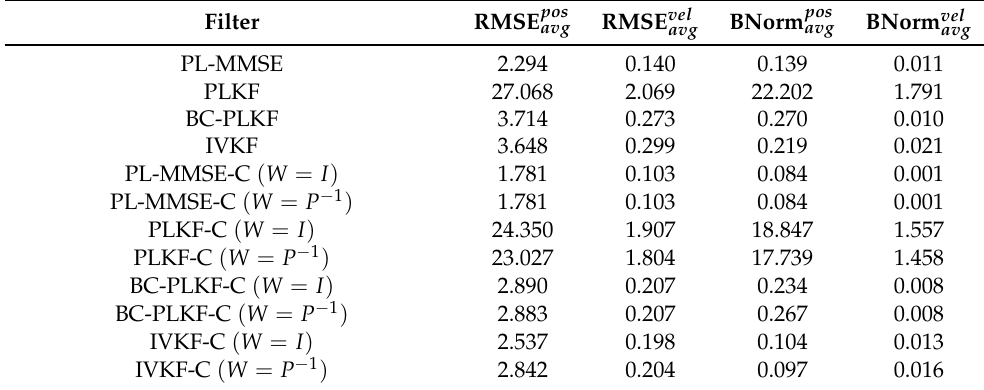
Table 5. RMSE pos avg ,RMSE vel avg ,BNorm pos avg and BNorm vel avg of different filters for σ θ = 7 ◦ at V = 12 m/s on the straight